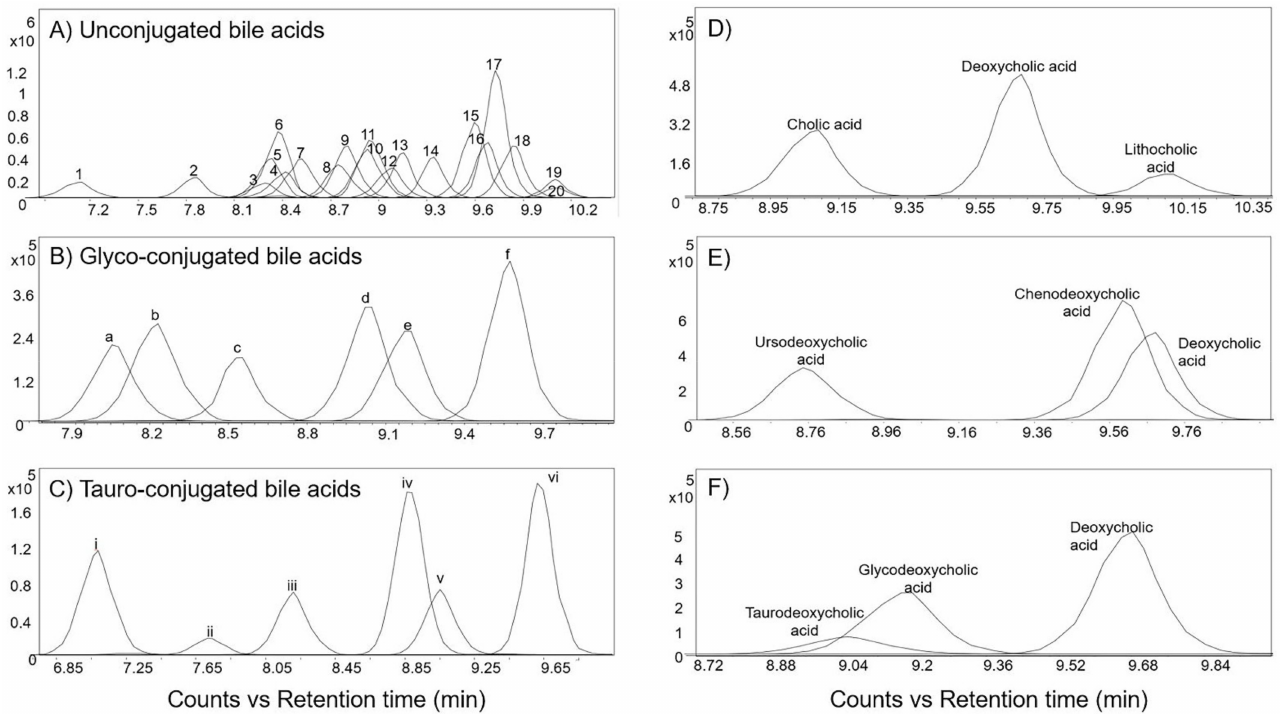
Figure 4. Extracted ion chromatogram of the base peak spectra of bile acids acquired from refer- ence “BACSMLS” standards in the positive ionization mode. ( A ) EICs of unconjugated bile acids. Peak identities are as follows: (1) dehydrocholic acid, (2) ursocholic acid, (3) 7-ketodeoxycholic acid (7-keto-3 α ,12- α -dihydroxycholanic acid), (4) 12-ketochenodeoxycholic acid ((3alpha,5beta,7alpha)- 3,7-dihydroxy-12-oxocholan-24-oic acid), (5) alpha-muricholic acid, (6) beta-muricholic acid, (7) murideoxycholic acid, (8) ursodeoxycholic acid, (9) gamma-muricholic acid (hyocholic acid), (10) 7-ketochenodeoxycholic acid (nutriacholic acid), (11) hyodeoxycholic acid, (12) cholic acid, (13) A=allocholic acid, (14) nordeoxycholic acid, (15) chenodeoxycholic acid, (16) deoxycholic acid, (17) 7 α - hydroxy-3-oxo-4-cholestenoic acid (7-HOCA), (18) coprocholic acid (3 α ,7 α ,12 α -trihydroxycoprostanic acid), (19) dehydrolithocholic acid (3-oxo-5 β -cholanoic acid), (20) lithocholic acid. ( B ) EICs of glycine- conjugated bile acids acquired from reference “BACSMLS” standards—(a) Glycoursodeoxycholic acid, (b) glycohyodeoxcholic acid, (c) glycocholic acid, (d) glycochenodeoxycholic acid, (e) glycodeoxy- cholicacid, (f) glycolithocholic acid. ( C ) EICs of taurine-conjugated bile acids—(i)